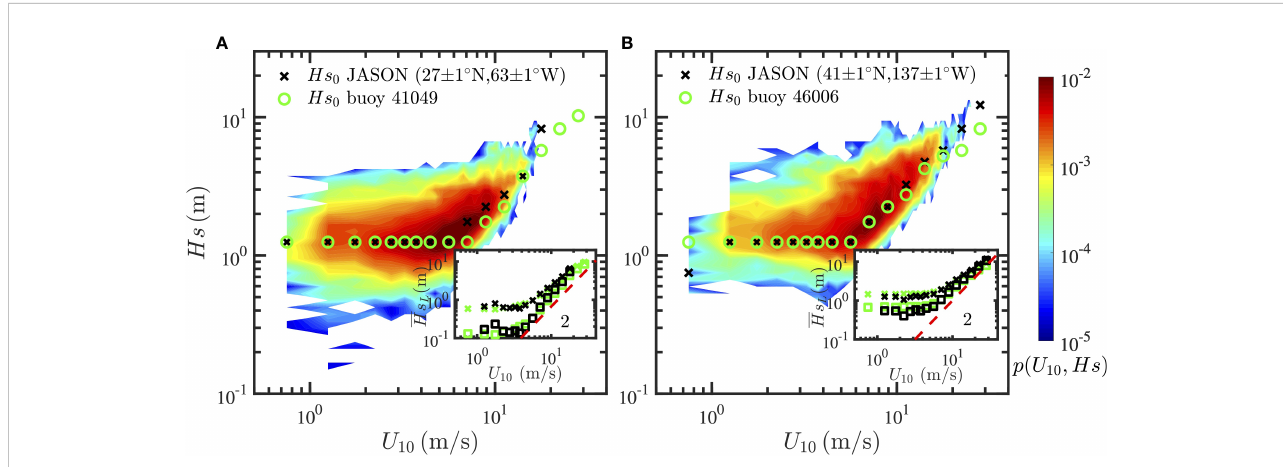
FIGURE 6 Measured joint PDFs of U 10 and Hs recorded by JASON in the areas close to NDBC buoys (A) 41049 and (B) 46006. The black crosses and green circles are the skeletons of the joint PDFs for JASON and buoy data. The insets show the measured (cid:1) Hs L , in which the squares and crosses indicate the (cid:1) Hs Ll from linear decomposition and the (cid:1) Hs Le from energy conserved decomposition, respectively. The colors green and black are used to indicate the results from buoy and satellite data. The dashed line is given as a reference with the slope of